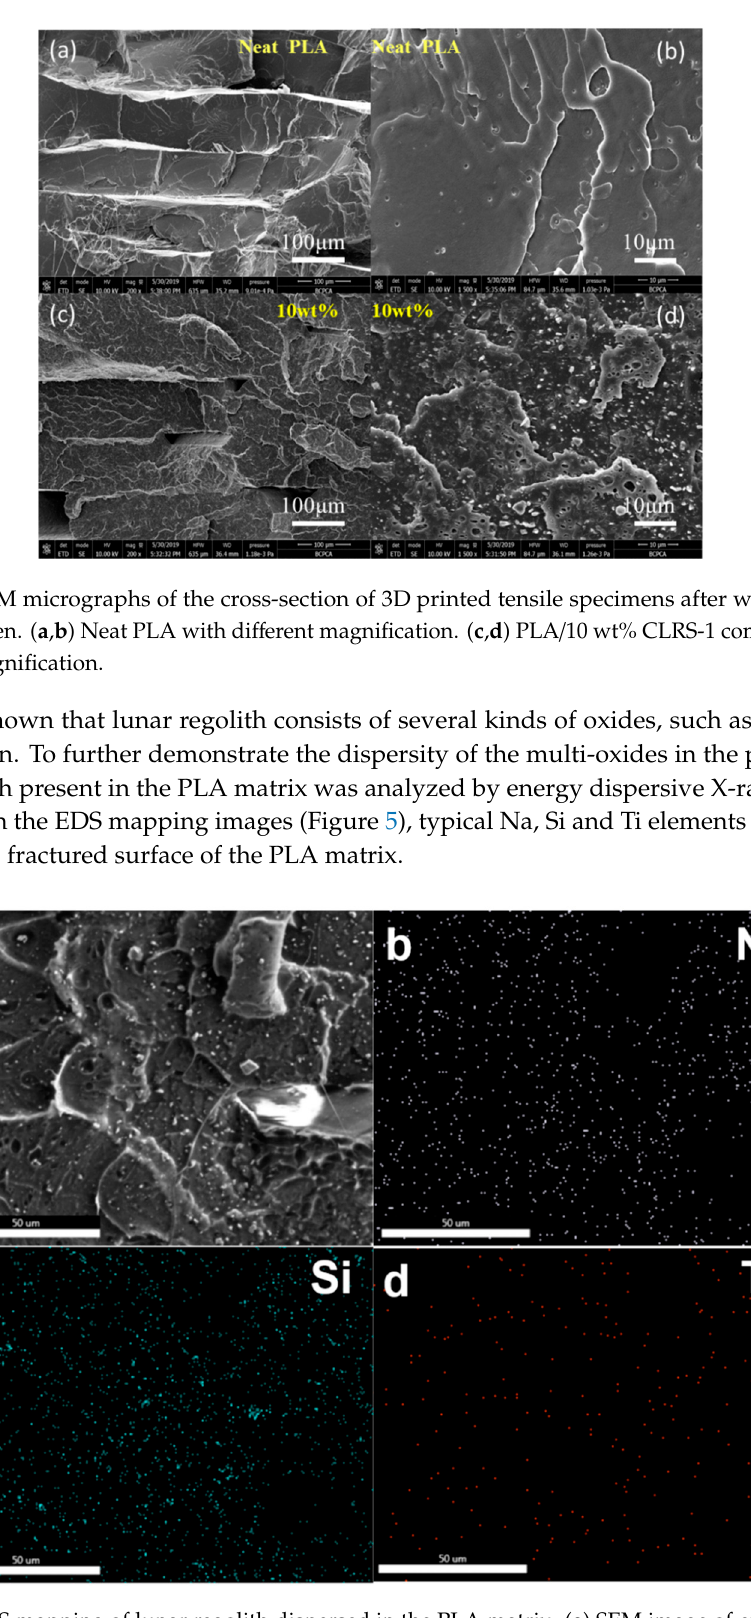
Figure 5. EDS mapping of lunar regolith dispersed in the PLA matrix. ( a ) SEM image of cross sections from PLA/CLRS-1 composites ( b ) Na; ( c ) Si; ( d ) Ti.